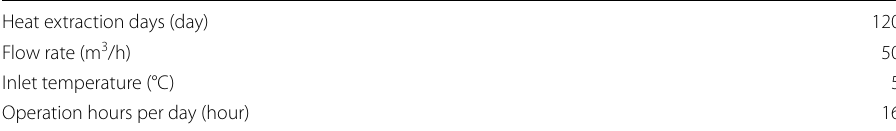
Table 5 Operation parameters of DBHE in the heating season Heat extraction days (day)